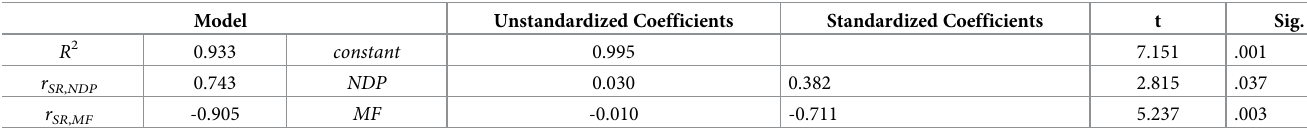
Table 6. The multiple linear regression analysis of SR on NDP and MF